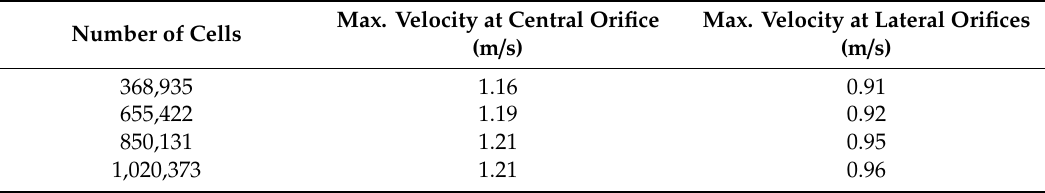
Table 1. Mesh independency test.